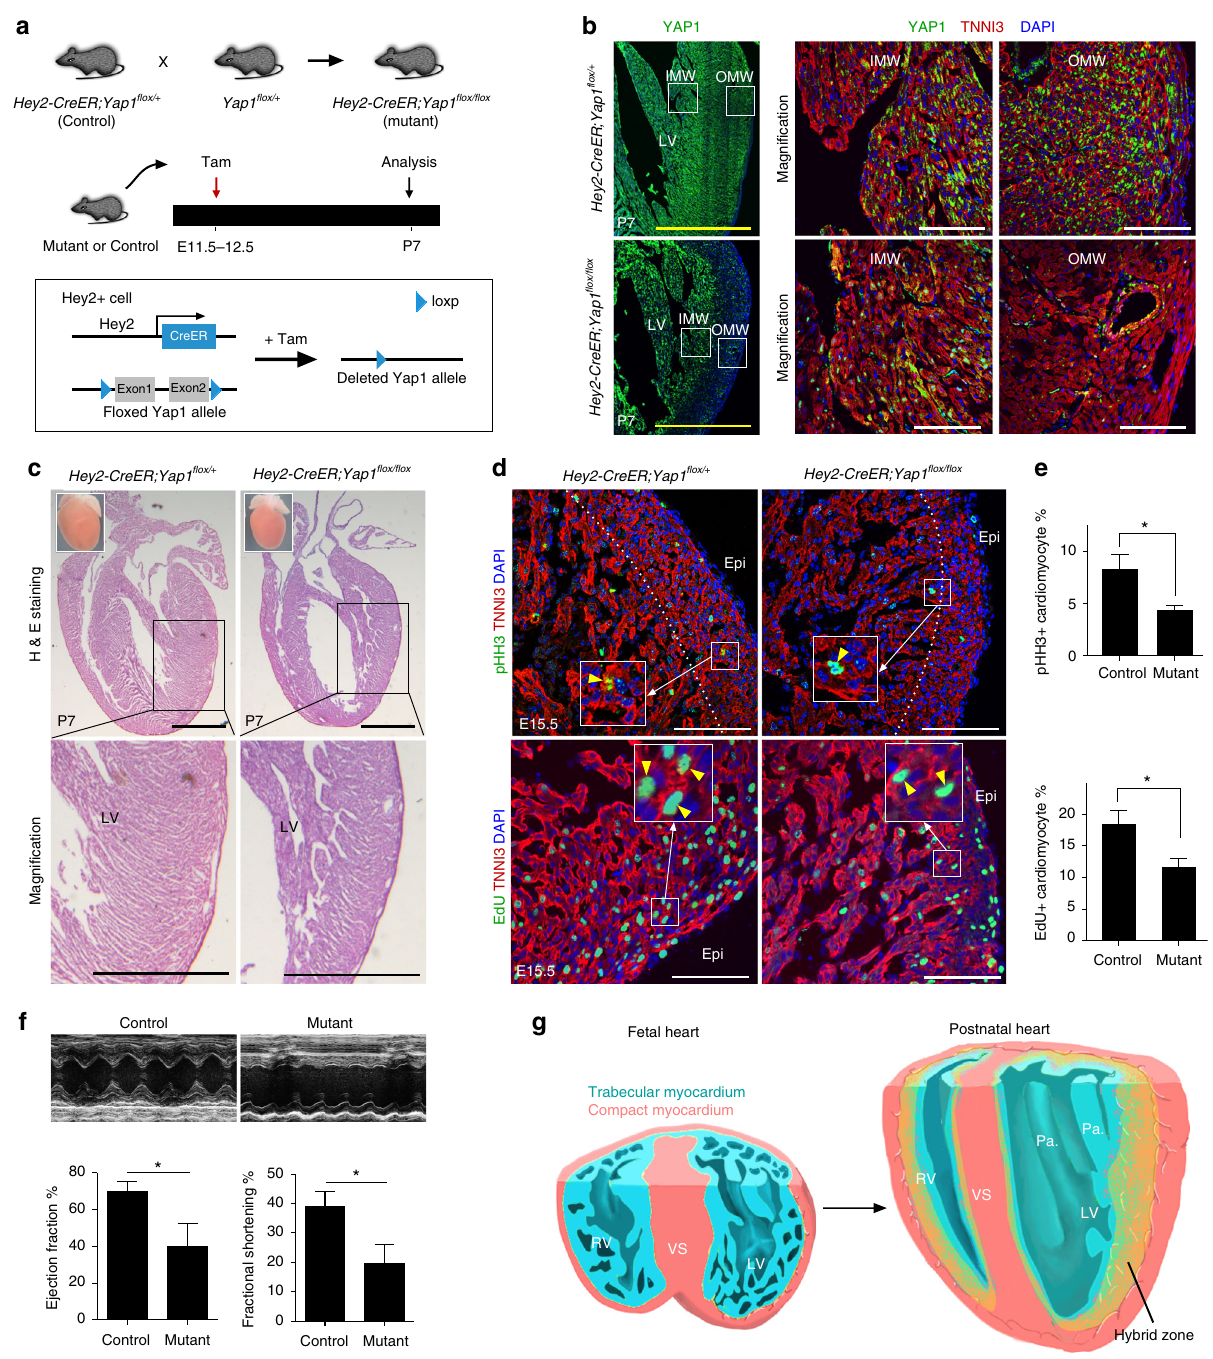
Fig. 9 Inhibition of fetal compact myocardial expansion results in prominent trabeculae and thin compacted layer of postnatal heart. a Schematic fi gure showing generation of Yap1 gene deletion in Hey2 + cells by tamoxifen injection at embryonic stage. b Immunostaining for YAP1 and TNNI3 on postnatal day 7 (P7) control and mutant heart sections. Although YAP1 is detected in the inner myocardial wall (IMW) of both control and mutant hearts, YAP1 is reduced in the outer myocardial wall (OMW) of mutant heart compared with that in the control heart. c Hematoxylin and eosin (H&E) staining of heart sections from P7 control ( left ) and mutant ( right ) mice. Inserts indicate whole-mount images of hearts. d Immunostaining for TNNI3 and pHH3 or EdU on control and mutant heart sections. Yellow arrowheads indicate proliferating cardiomyocytes in the magni fi ed inserts. e Quanti fi cation on the percentage of pHH3 + or EdU + cardiomyocytes is shown on the right panel . f Echocardiographic analysis of heart function showed a signi fi cant reduction of ejection fraction and fractional shortening in the mutant, compared with the control. * P < 0.05; n = 4 for mutant and n = 5 for control. g Cartoon image showing hybrid myocardial zone in the postnatal heart derived from trabecular layer and compact myocardium. The hybrid zone ( yellow ) is interposed between the inner myocardial wall ( blue ) produced mainly by trabecular coalescence and the outer myocardial wall ( red ) produced by compact myocardial expansion. RV right ventricle, LV left ventricle, VS ventricular septum; Pa . papillary muscle. Scale bars, 1 mm ( black or yellow ); 100 µ m ( white